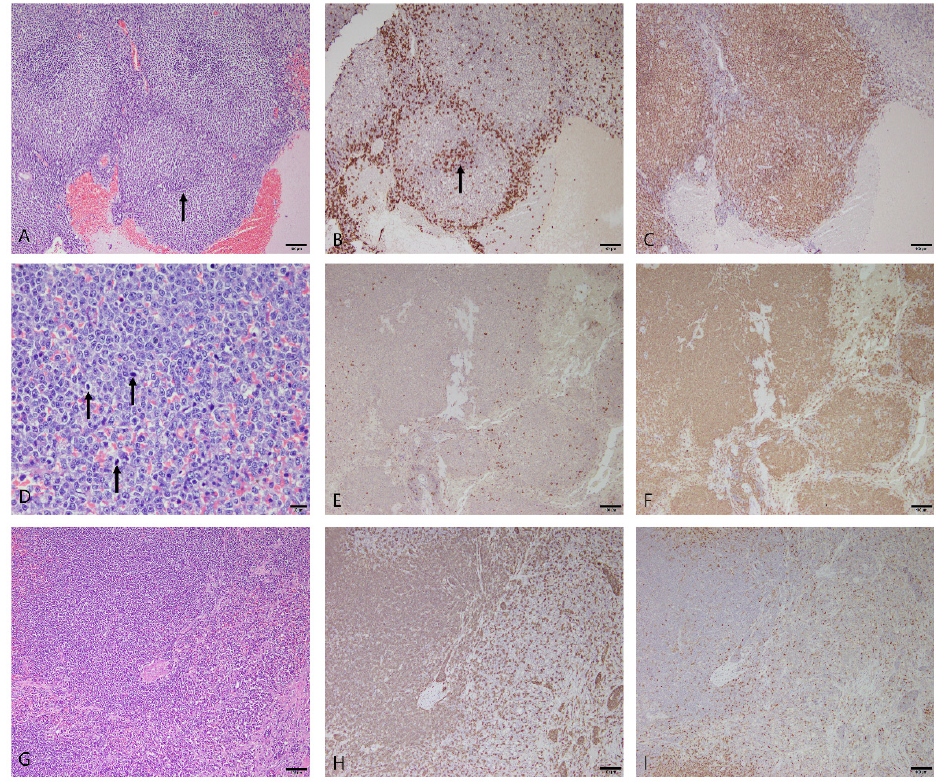
Figure 4. ( A – C ) Marginal-zone lymphoma in the spleen of a dog. ( A ) Nodular growth pattern, with proliferating marginal zone and fading germinal center (arrow). Hematoxylin and eosin (H&E) at 100× magnification. Scale bar = 100 µm. ( B ) Immunohistochemical staining for CD3 with Mayer’s hematoxylin counterstain. CD3-immunopositive cells were scattered at the periphery of the follicles, with small clusters in the fading germinal center (arrow). 100× magnification. Scale bar = 100 µm. ( C ) Immunohistochemical staining for PAX5 with Mayer’s hematoxylin counterstain. PAX5 was prominently expressed in the follicles. 100× magnification. Scale bar = 100 µm. ( D – F ) Diffuse large B-cell lymphoma in the spleen of a dog. ( D ) Large lymphocytes showed severe anisokaryosis, with prominent nucleoli and frequent mitotic figures (arrows). H&E at 400× magnification. Scale bar = 20 µm. ( E ) Immunohistochemical staining for CD3 with Mayer’s hematoxylin counterstain. Neoplastic cells were immunonegative for CD3. 100× magnification. Scale bar = 100 µm. ( F ) Immunohistochem- ical staining for PAX5 with Mayer’s hematoxylin counterstain. Neoplastic cells were diffusely im- munopositive for PAX5. 100× magnification. Scale bar = 100 µm. ( G – I ) Peripheral T-cell lymphoma in the spleen a dog. ( G ) Diffuse growth pattern of neoplastic lymphocytes was observed. H&E at 100× magnification. Scale bar = 100 µm. ( H ) Immunohistochemical staining for CD3 with Mayer’s hematoxylin counterstain. Neoplastic cells were diffusely immunopositive for CD3. 100× magnifi- cation. Scale bar = 100 µm. ( I ) Immunohistochemical staining for PAX5 with Mayer’s hematoxylin counterstain. Neoplastic cells were immunonegative for PAX5. 100× magnification. Scale bar = 100 µm. 3.2.5. Stromal Sarcomas Ten dogs were diagnosed with splenic stromal tumors, most of which were Maltese (n = 8). The other breeds were the bichon frise (n = 1) and Labrador retriever (n = 1). The average age at diagnosis was 11.4 years (range: 10–14 years), and there were eight cas- trated males and two spayed females. Histologically, all stromal sarcomas were poorly demarcated and infiltrated into the surrounding parenchyma. The neoplastic cells were spindle-shaped with collagen deposition and formed broad fascicles that ran in diverse directions (Figure 5A). The cytoplasm was elongated to an oval appearance and showed pleomorphism. The nuclei were variable in size and shape, and some had multiple